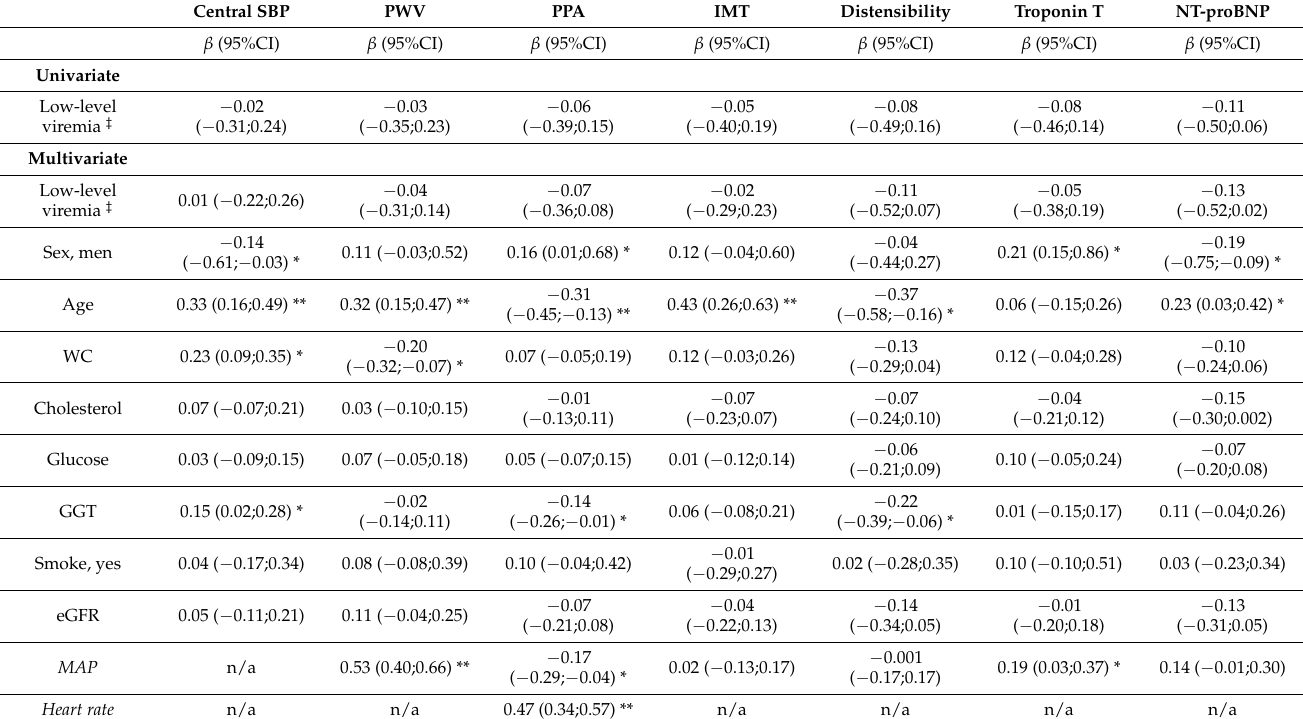
Table 2. Independent associations between cardiovascular measures and viremia status ( n =